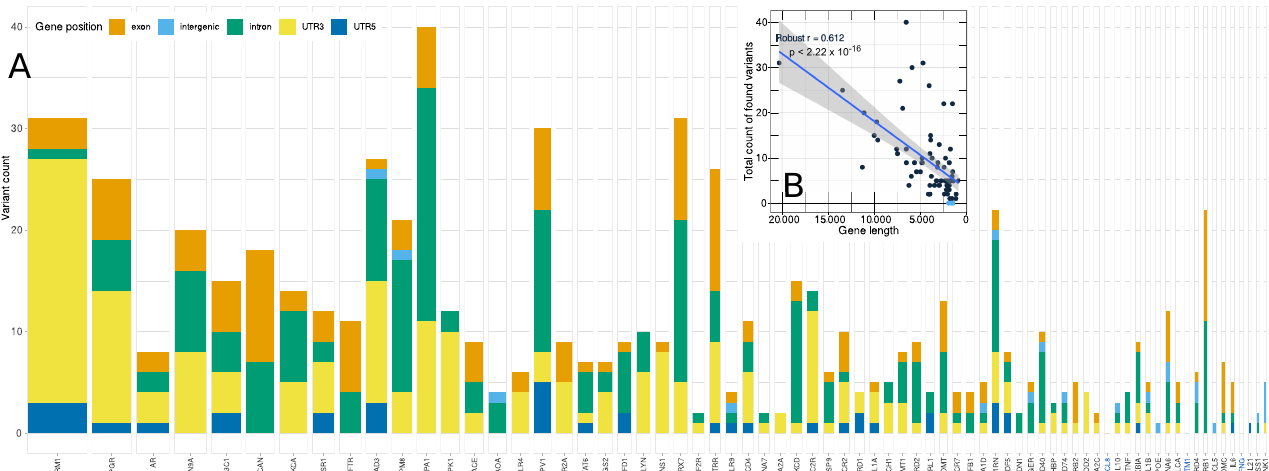
Figure 3. . Figure 3. Number and localization of variants identified using the present AmpliSeq TM panel, in relation to the read DNA length per gene. ( A ) Stacked bar plot representing the number of genetic variants per gene included in the assay, categorized for the gene locations. The horizontal size of the cells is proportional to the number of nucleotides assayed in the respective gene. The genes are ordered for descending read length. Variants were not found in three genes ( IFNG , GSTM1 and CXCL8 ; indicated in blue gene symbols at the x -axis), which are among the shortest genes. ( B ) Scatterplot of the total number of variants versus the number of nucleotides read for the respective gene in the present assay. A robust regression line with 95% confidence interval is overlaid on the dot plot. The genes where no variants had been detected are indicated as blue dots. Please note the decreasing order of gene length on the abscissa to match the main panel. The figure has been created using the R software package (version 4.0.2 for Linux, city, http://CRAN.R-project.org/ [92]) and the R libraries “ggplot2” (https://cran.r-project.org/package=ggplot2 [96]). UTR: untranslated